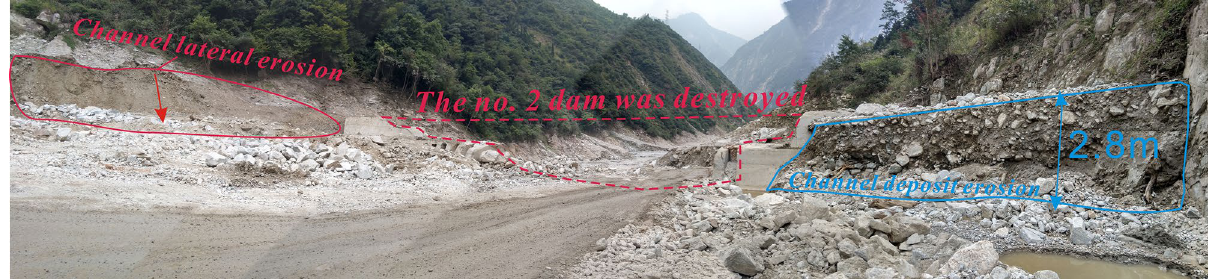
Figure 13. Longitudinal cross-section of the “8.20” debris flow